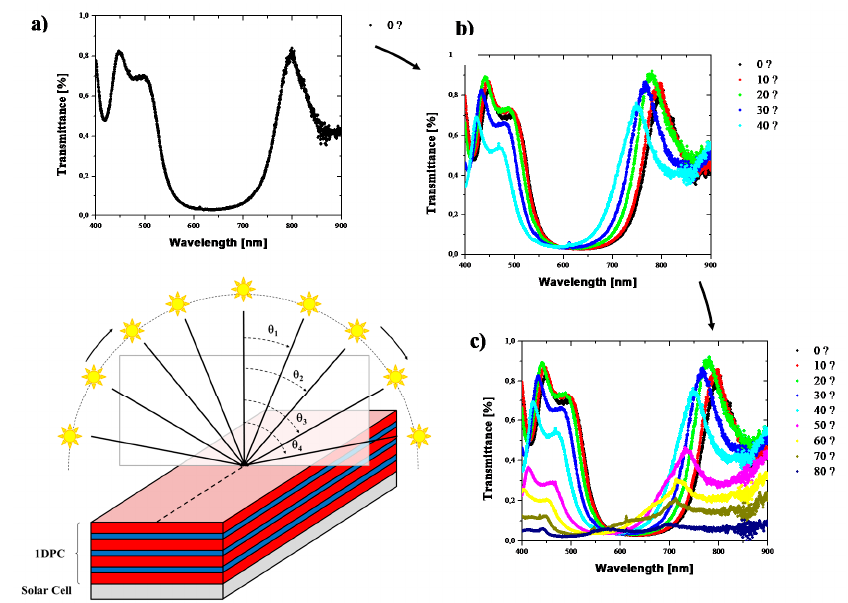
Figure 4. Transmittance of 1DPC as a function of the incident angle. As incident angle is increased, Bragg peak is shifted to a lower wavelength.